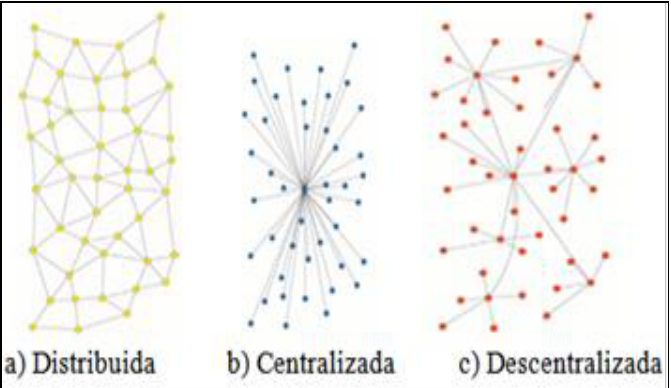
Figura 1: Arquitecturas de las Redes. Fuente: Los autores, (2018).